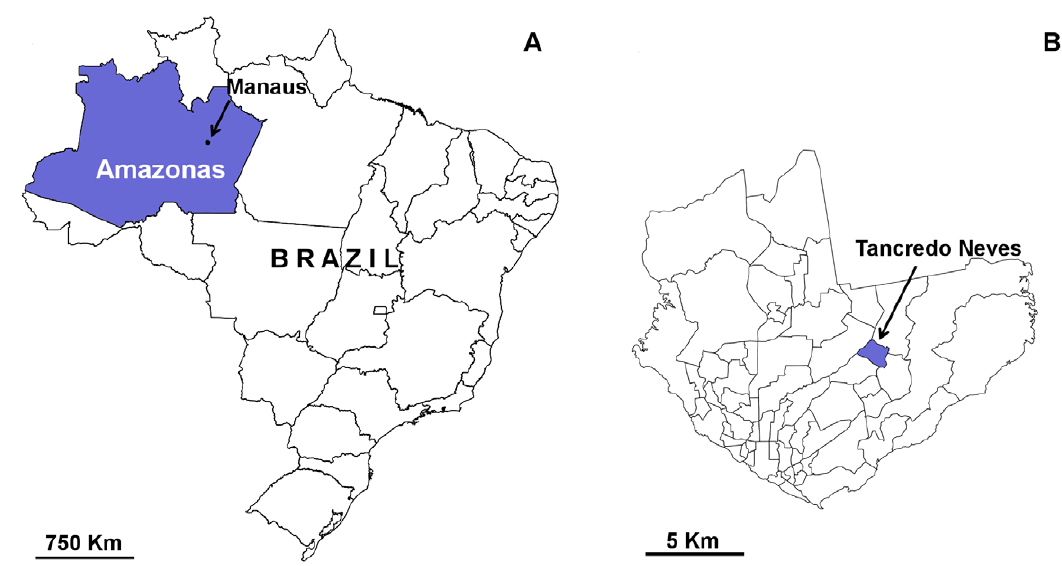
Figure 1. Study area. Manaus, state of Amazonas, Brazil (A) and Tancredo Neves neighborhood (B).